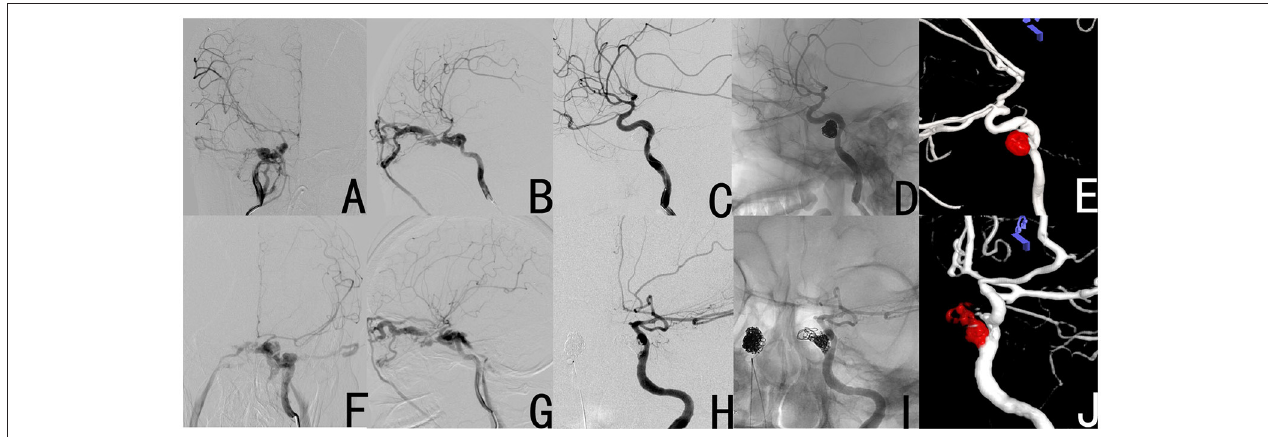
FIGURE 4 | Case 8 had bilateral CCFs, and these were completely occluded by simple coil embolization of the fistula. The preoperative DSA revealed the right CCF (A,B) . The post-operative DSA revealed that the fistula disappeared (C–E) . The preoperative DSA revealed the left CCF (F,G) . The post-operative DSA revealed that the fistula disappeared (H–J) .